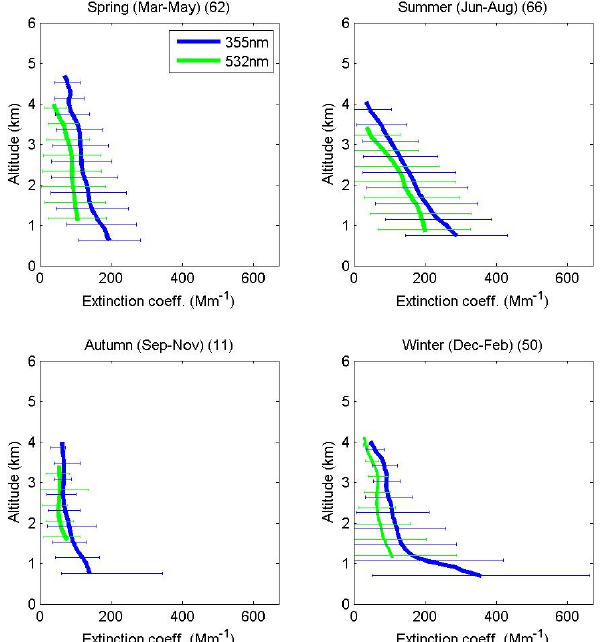
Fig. 4. Seasonal averaged extinction profiles at two wavelengths Figure 4. Seasonal averaged extinction profiles at two wavelengths with standard with standard deviations for the Gual Pahari site. The value in the deviations for the Gual Pahari site. The value in the plot title indicates the number of plot title indicates the number of profiles used in calculations for profiles used in calculations for each season. each